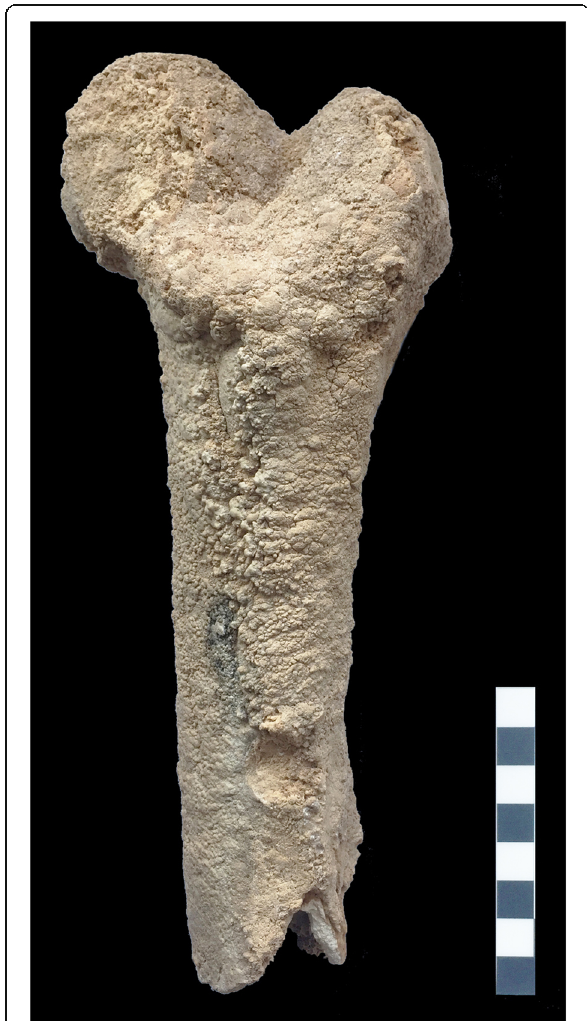
Fig. 2 Photograph of the preserved fragment of a proximal femur fragment completely covered by a thick layer of calcium carbonate. The gross anatomical identification and the orientation of the bone are evident due to the specimen ’ s overall morphological characteristics; a thick concretion covering the entire bone fragment, however, obscures all finer morphological